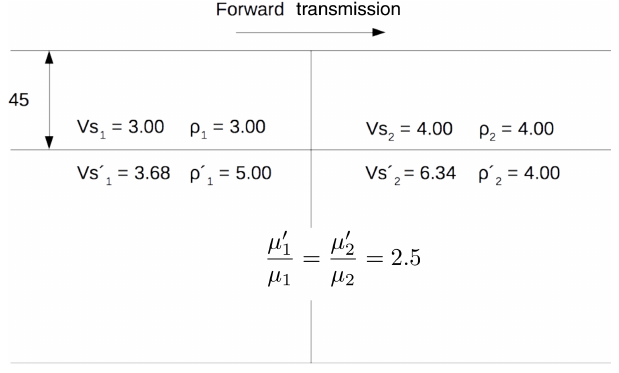
Figure 5. Schematic representation of the model of Sato (1961). Units of layer parameters are the same as in Fig.